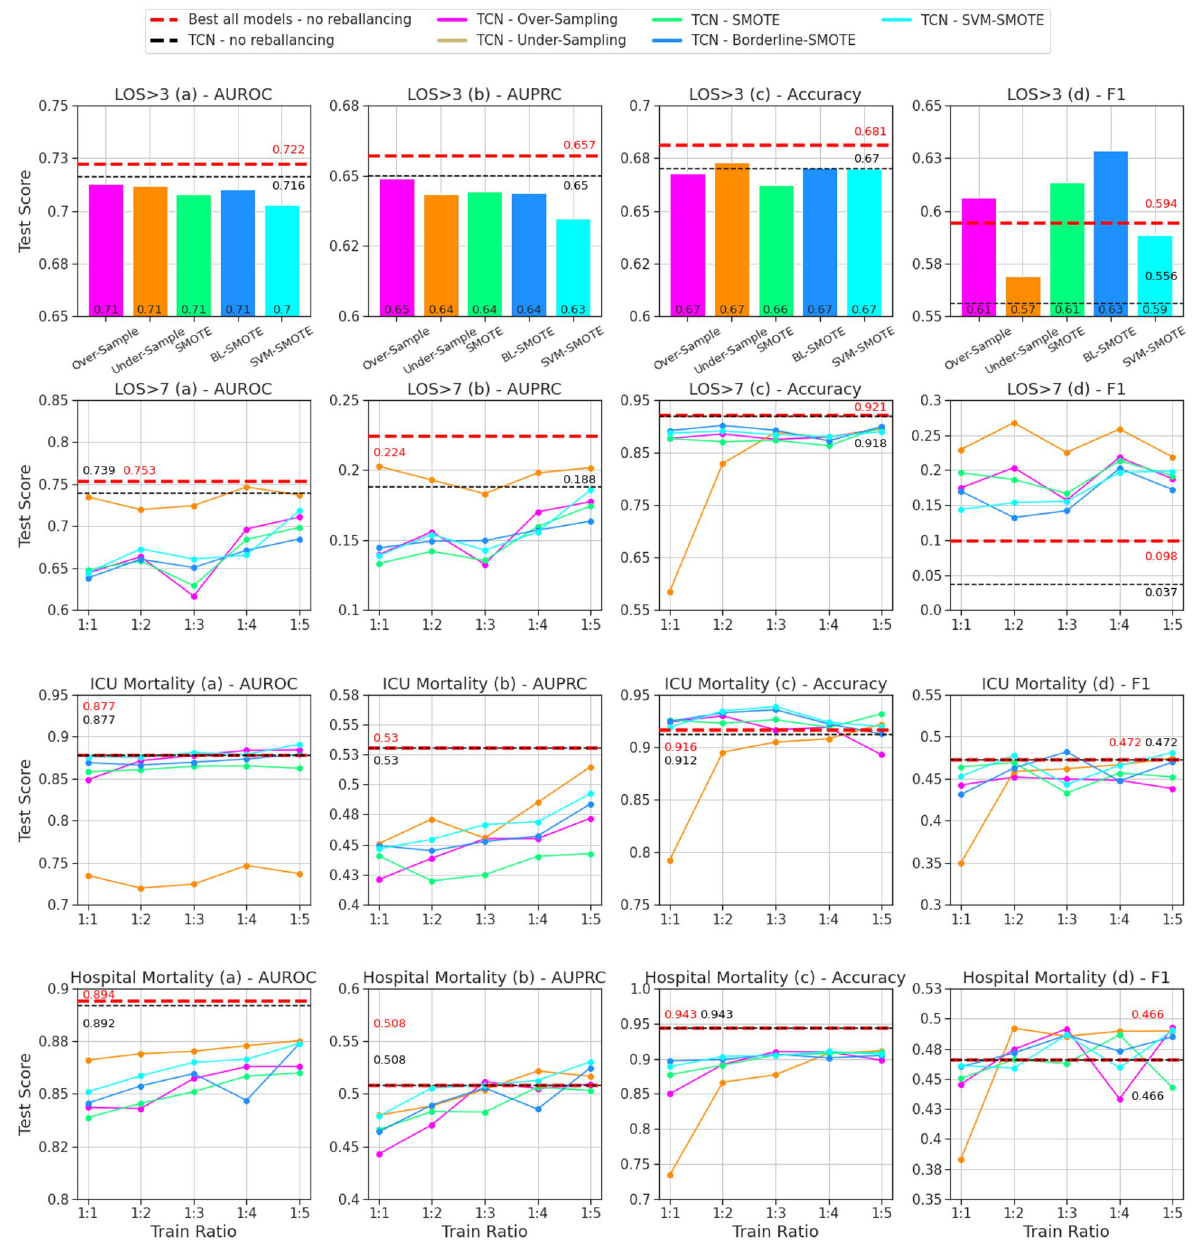
represent TCN and best-in-task (all models) performance without rebalancing. For the three tasks where possible (LOS > 7, ICU mortality, hospital mortality), methods are evaluated for rebalancing ratios of 1:1, 1:2, 1:3, 1:4, and 1:5, otherwise only 1:1. TCN, temporal convolutional network; AUROC, area under the receiver- operating characteristics; AUPRC, area under the precision-recall curve; LOS, length of stay; BL, borderline; SVM, support vector machine; SMOTE, synthetic minority oversampling